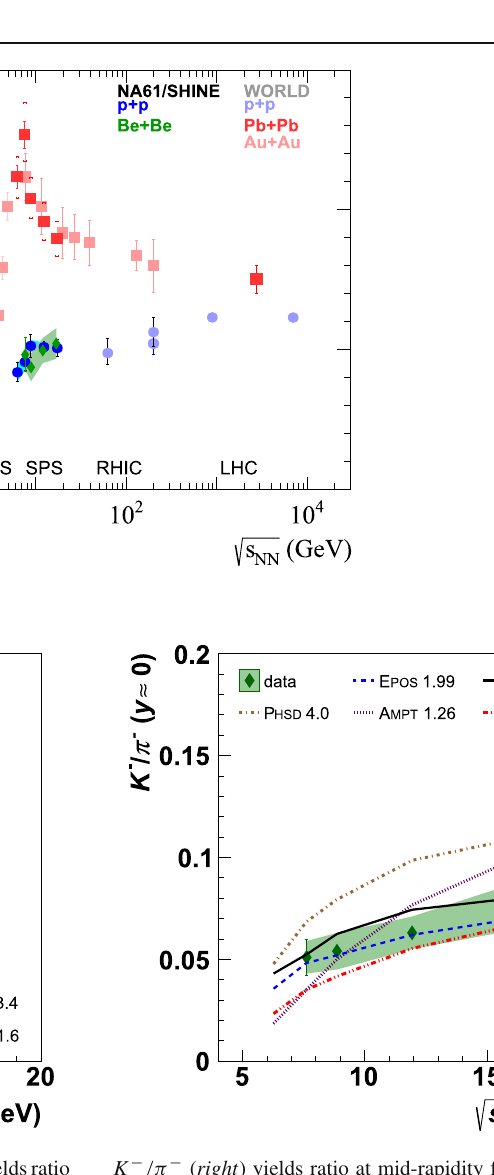
K − /π − ( right ) yields ratio at mid-rapidity for the 20% most central Be+Be collisions with models: Epos 1.99 (blue dashed line), U r qmd 3.4 (black solid line), Ampt 1.26 (violet dotted line), Phsd 4.0 (brown dashed-dotted line) and Smash 1.6 (red dashed-double dotted